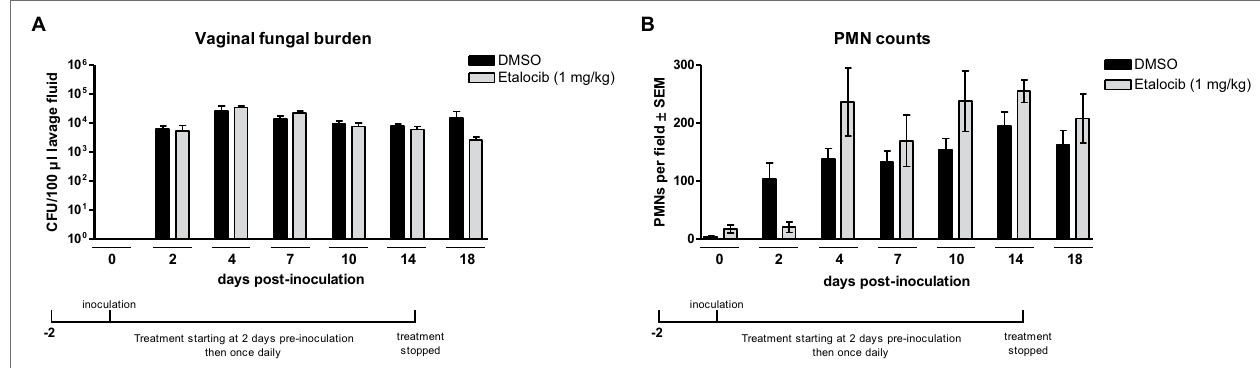
FIGURE 1 | Treatment with a LTB 4 receptor antagonist Etalocib does not reduce PMN migration to the vaginal cavity following inoculation with C. albicans. Estrogenized C3H mice were administered Etalocib (1 mg/kg) or vehicle alone (10% DMSO) in a volume of 100 μ l by i.p. injection on 2 days prior to inoculation then once daily for 16 days. Mice were intravaginally inoculated with 5 × 10 4 C. albicans 96,113. Vaginal lavage fluid was collected longitudinally over a period of 18 days post-inoculation. (A) Vaginal fungal burden was assessed by quantitative plate counts at the indicated time points. (B) Vaginal cellular infiltrates were stained by the Pap smear technique and examined by light microscopy at x400 magnification. Number of PMNs were quantified in 5 nonadjacent fields per sample and averaged. Data represent cumulative results of 1 longitudinal experiment performed with 4–5 animals/group. Data were analyzed by using the unpaired Student’s t